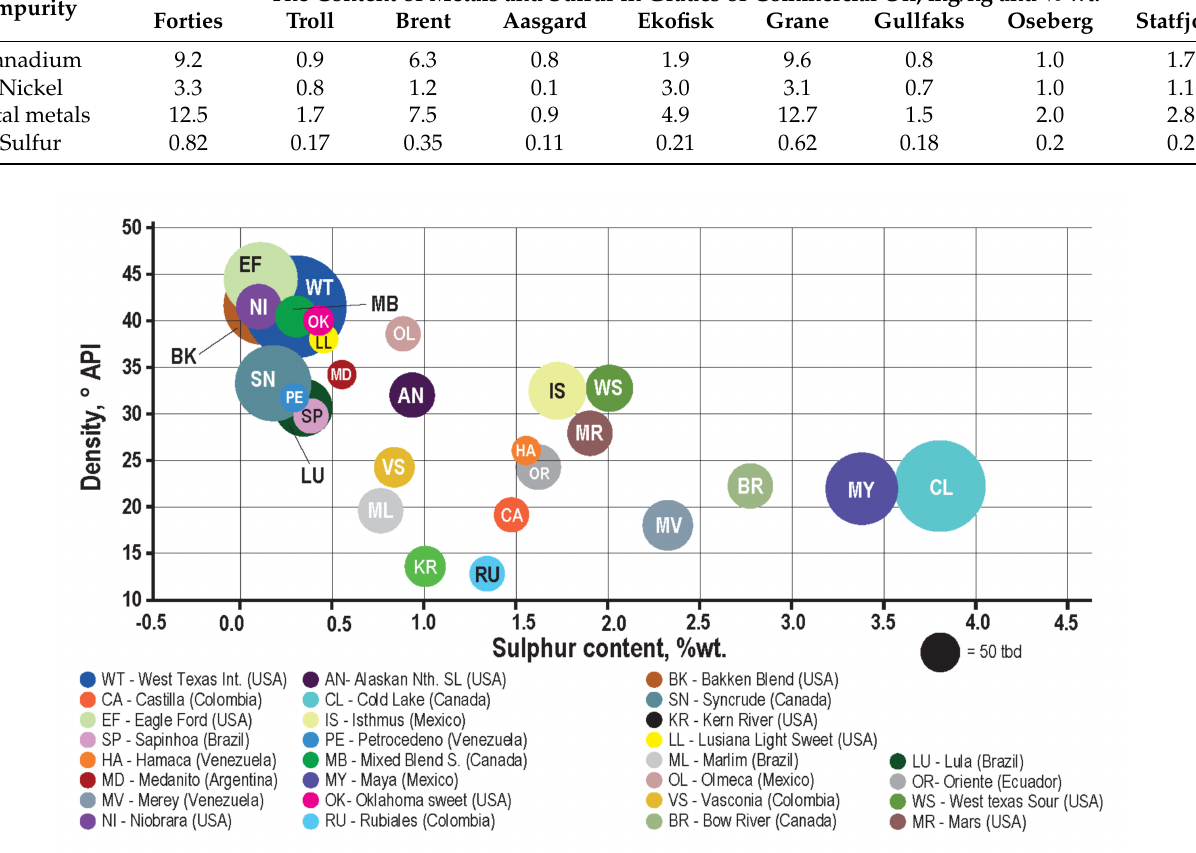
Figure 18. Quantity and quality of American oil